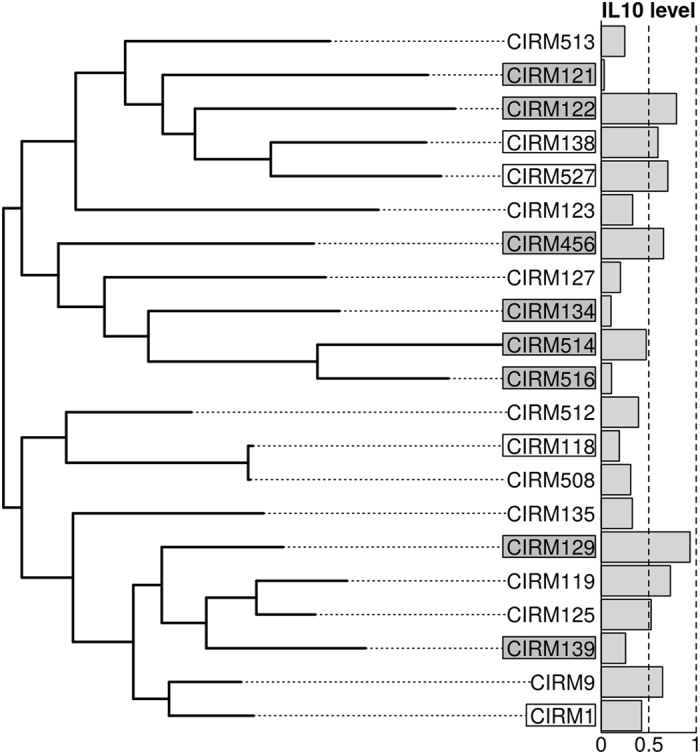
Maximum likelihood phylogenetic tree (JTT + I + G) of the Propionibacterium freudenreichii strains used in this study.The 12 strains shown in boxes were used in the proteomics study and the eight strains with a grey background were also used in the transcriptomics study. IL-10 levels were normalised within each donor using B. longum (BB536) induced levels as a reference and averaged over four donors.